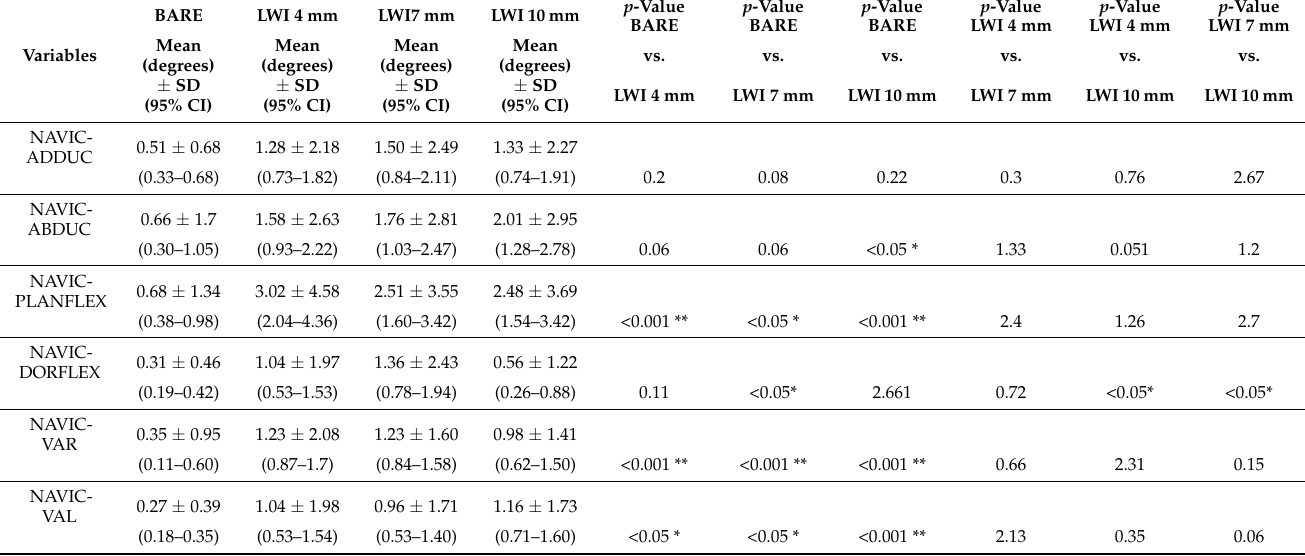
Table 5. The data of the navicular bone sensor movement under the four conditions.